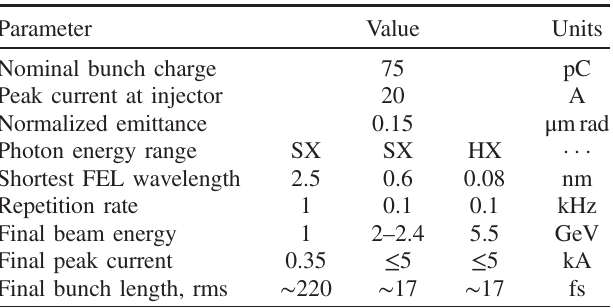
TABLE I. Electron beam parameters for the CompactLight